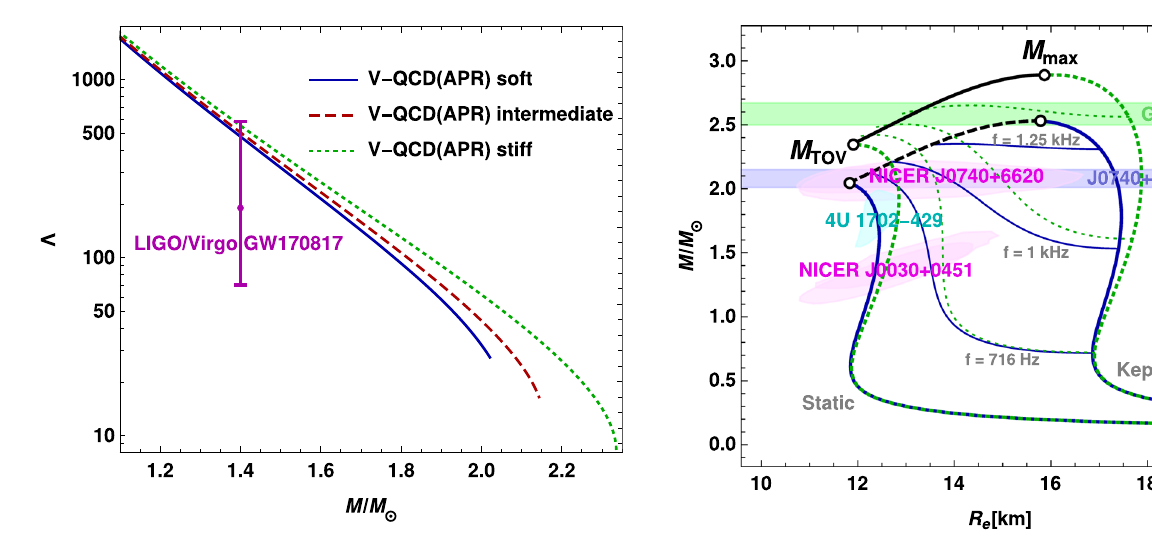
Fig. 19 Mass-radius curves for the V-QCD(APR) EOSs including rotating stars. Blue (green dotted) curves are for the soft (stiff) V- QCD(APR)EOS.The(dashedandsolid)blackcurvesmarklineswhere the maximal central density is reached. The circles show the maximal nonrotating M TOV androtating M max masses.Shownisalsoexperimen- tal data for masses and radii of compact objects. See text for detailed